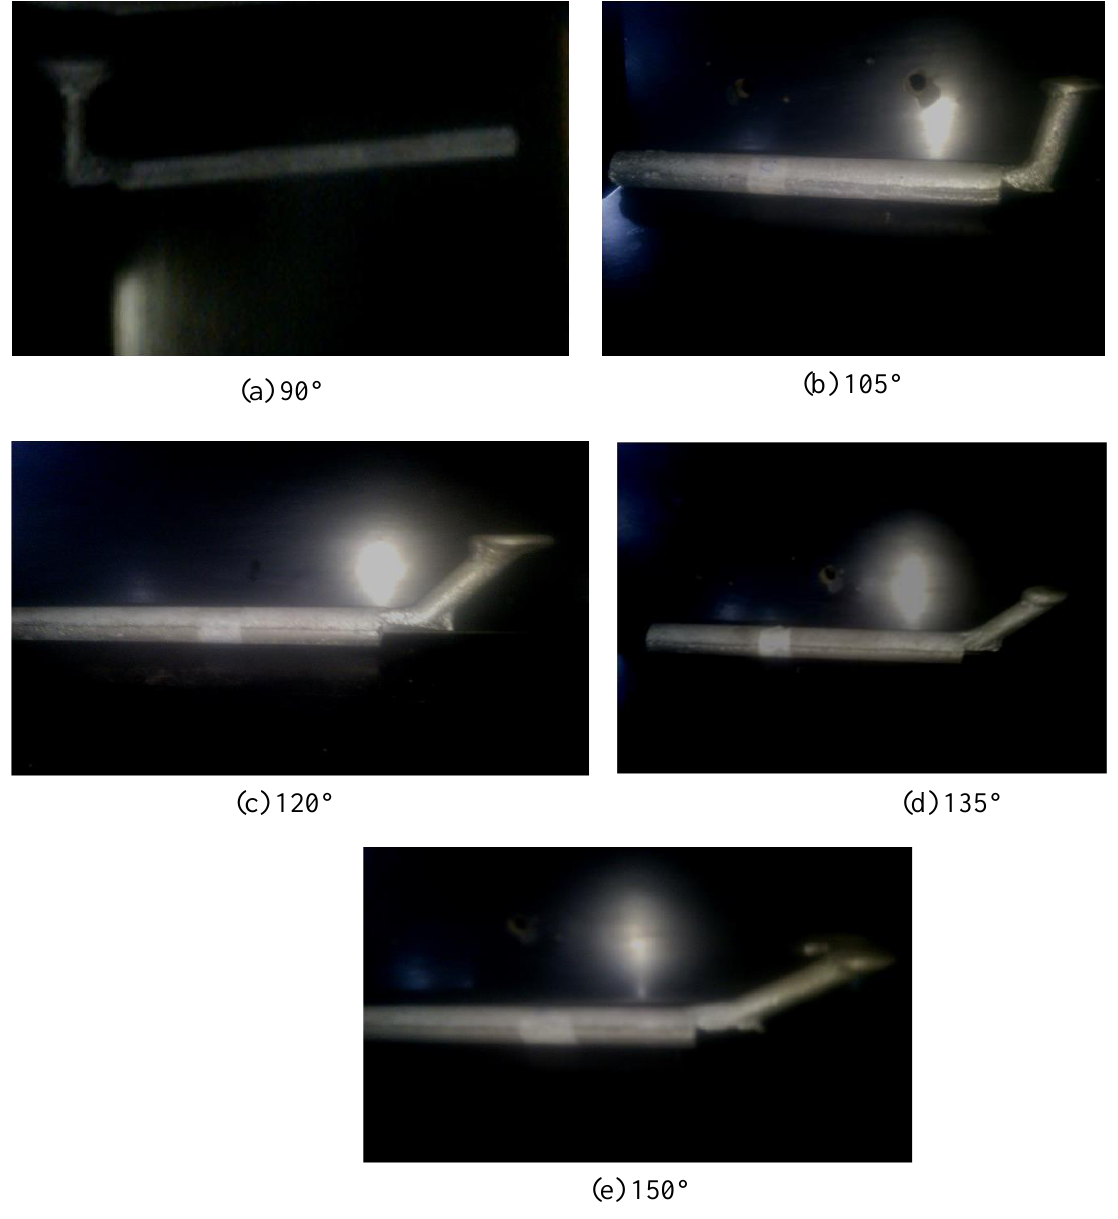
Fig. 1. Cast samples at varied runner